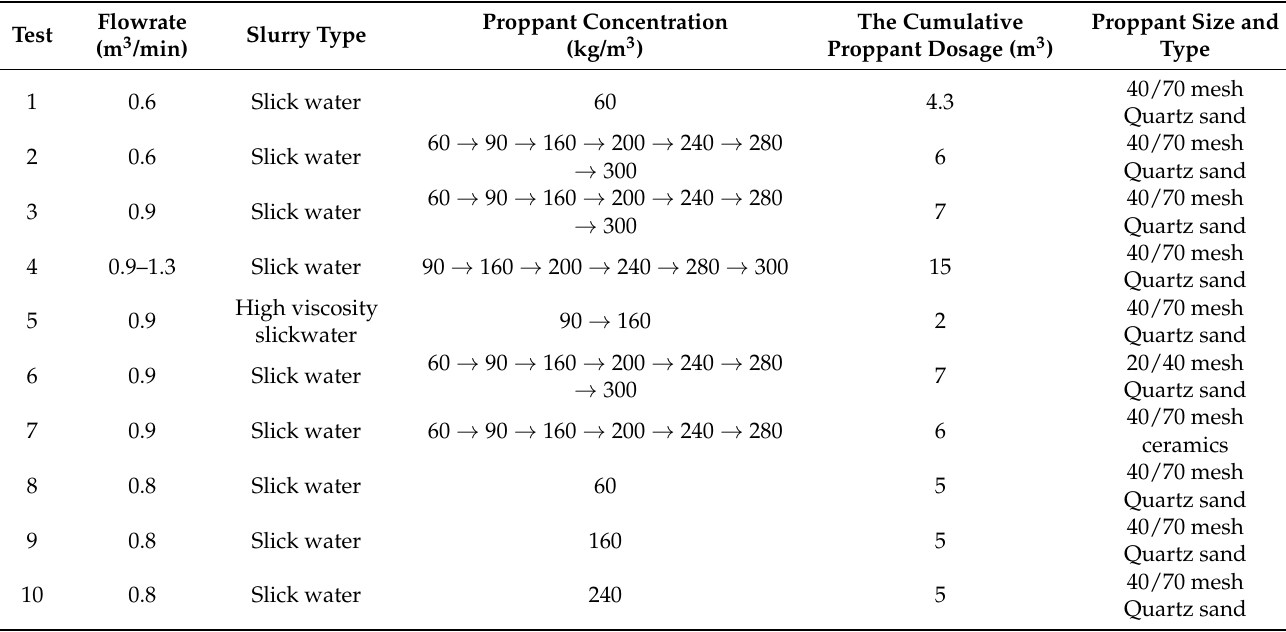
Table 1. Experimental